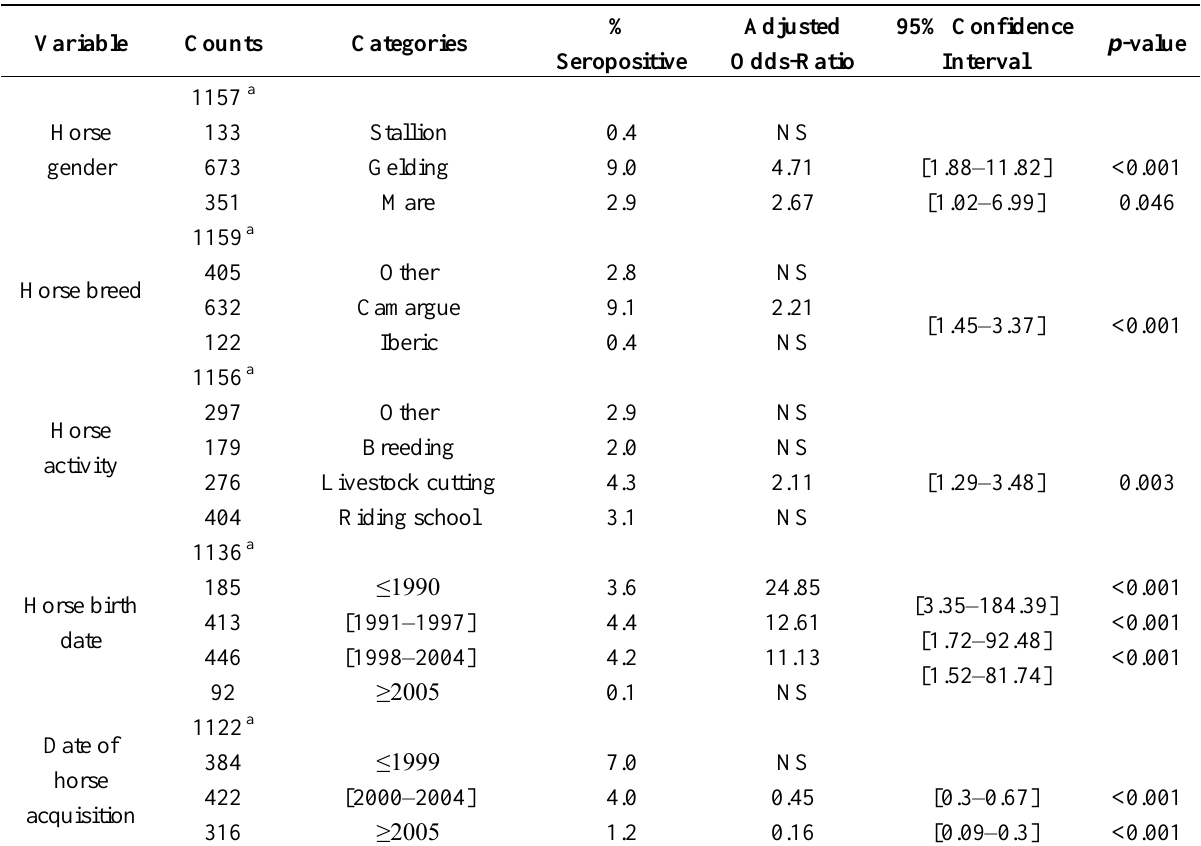
Table 3. Distribution and results of the univariate analysis for the horse-level explanatory variables tested for their association with the serological status of West Nile Virus in equids in Southern France,